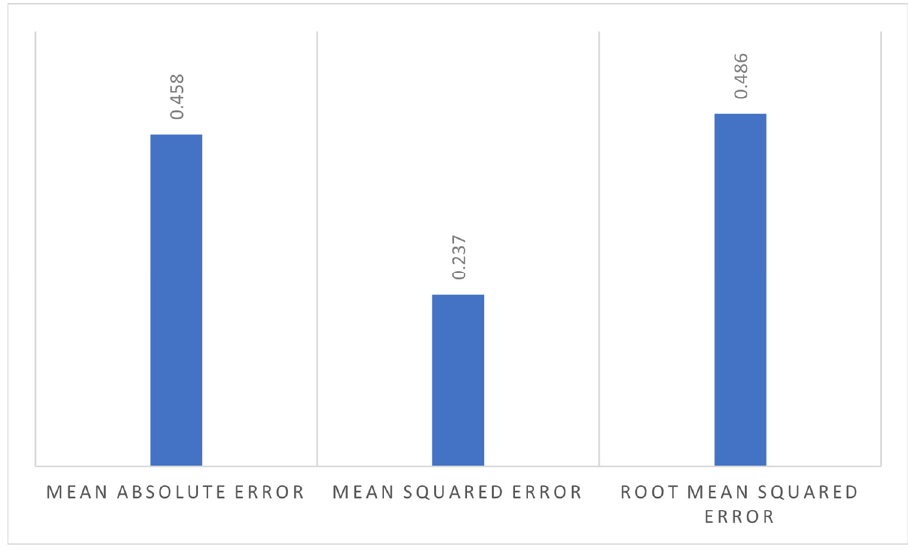
Figure 5. Simulation errors for the years